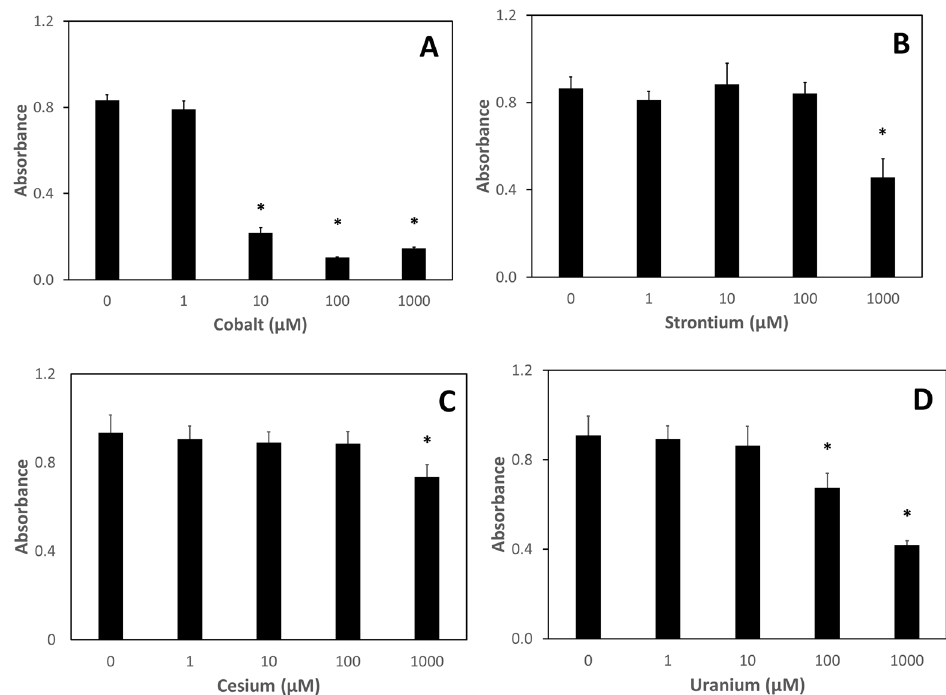
Figure 3. Metabolic viability of J774 cells after treatment with metals. J774 cells were treated with various concentrations of metals for 24 h after which metabolic viability was assessed using the MTT assay: ( A ) cobalt; ( B ) strontium; ( C ) cesium; ( D ) uranium. Data are the mean of three independent experiments. Error bars represent standard deviation. An * denotes a result statistically different from the no metal control as determined by unpaired t-test with significance at p < 0.05.